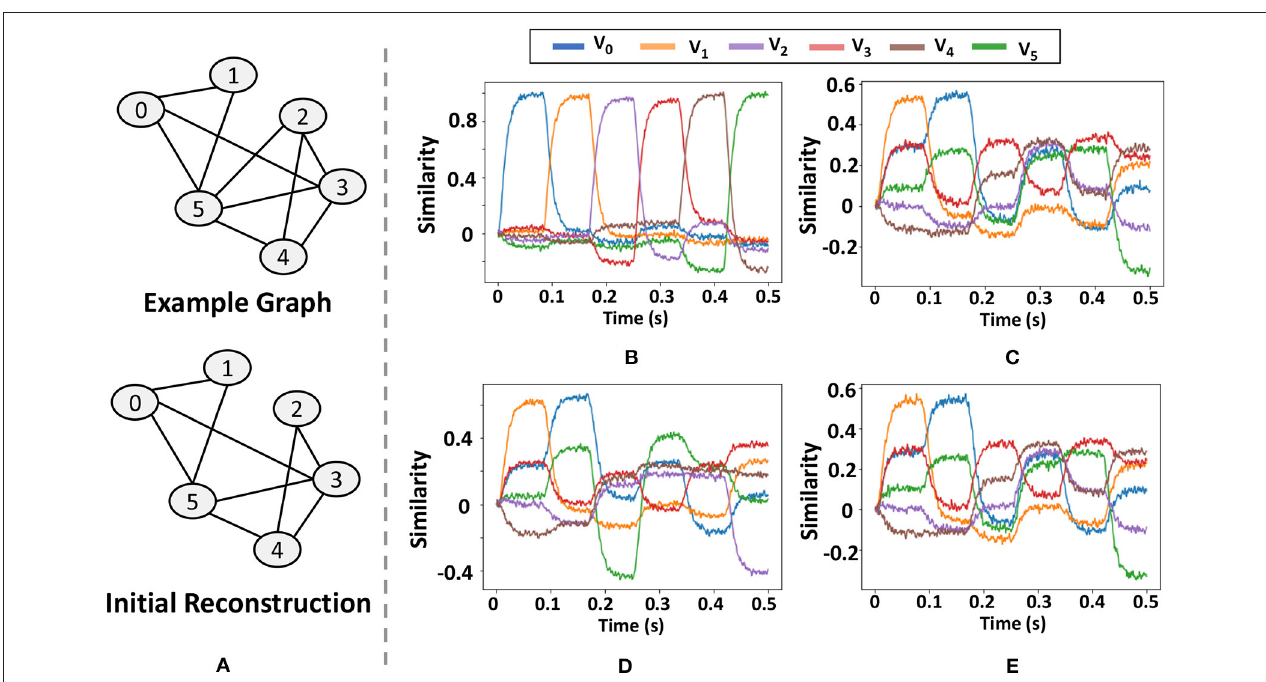
FIGURE 14 | Results of the graph decoding process on neuromorphic hardware. (A) graph structure and the initial reconstructed graph, (B) similarity of the query vector with each of the nodes, (C) similarity with each of the node vector with graph memory of the model, (D,E) output of the graph decoding process in the first (D) and second iterations (E)